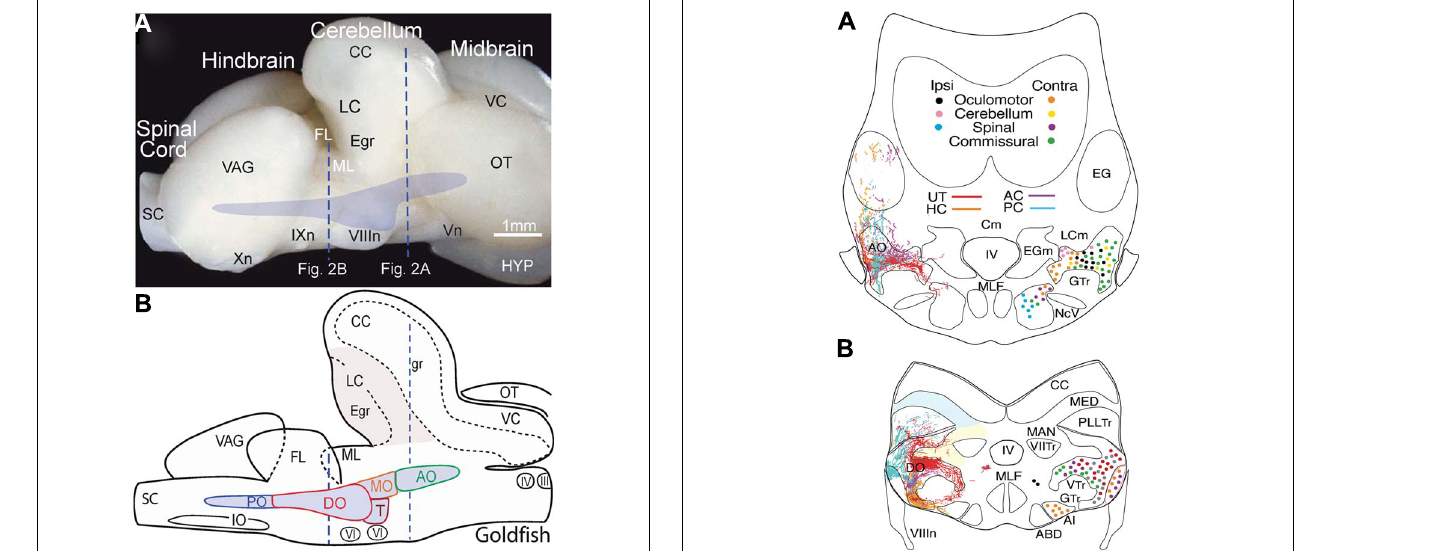
FIGURE 2 |Afferent and efferent vestibular pathways in adult goldfish. Schematic cross sections at the level of r3 (A) and r5 (B) showing first order canal and utricular afferent terminations. Efferent projections to ipsi- and contralateral extraocular, spinal, cerebellar, and vestibular targets are color-coded. Reconstruction based on own data (Straka and Baker, unpublished) and published material (McCormick and Braford, 1994). AI, abducens internuclear neurons; ABD, abducens motoneurons; AO, DO, anterior, descending octavolateral nucleus; CC, cerebellar crest; EG, eminentia granularis; LC, caudal lobe; MAN, medial auditory nucleus; MED, lateral line medial nucleus; MLF, medial longitudinal fasciclus;T, tangential nucleus; GTr, secondary gustatory tract; PllTr, posterior lateral line tract;VTr, descending tract of theVth cranial nerve;VIITr, central tract of the seventh cranial